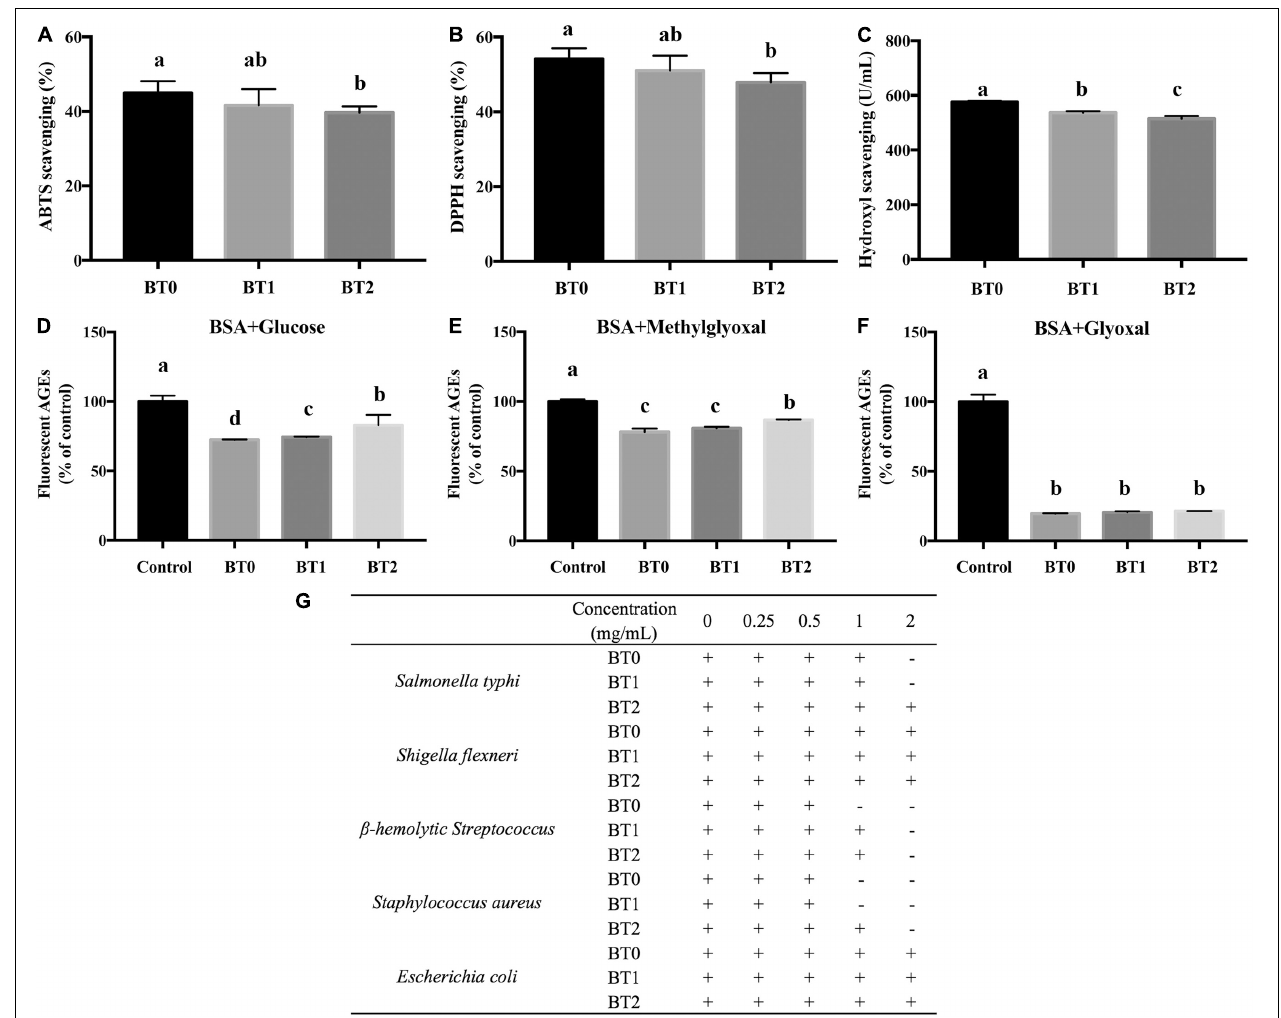
FIGURE 3 | Bioactivities of jade (BT0), medium baked (BT1), and deep baked (BT2) Tieguanyin oolong teas. (A) ABTS scavenging activity; (B) DPPH scavenging activity; (C) hydroxyl scavenging activity; relative fluorescent AGEs formation in the bovine serum albumin (BSA) + glucose system (D) , BSA + methylglyoxal system (E) , and BSA + glyoxal system (F) ; (G) minimum inhibitory concentrations of the three tea extracts against five bacteria. “+” means visible growth of the bacteria, while “–” means no visible bacterial growth. The same letter within each column indicates no significant difference ( P >